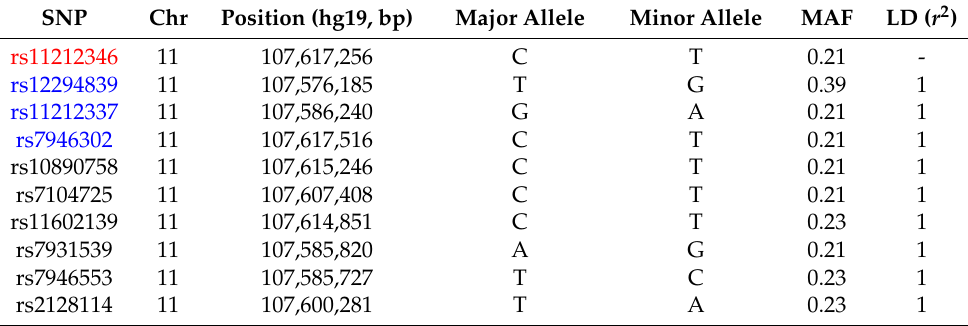
107,600,281 T A 0.23